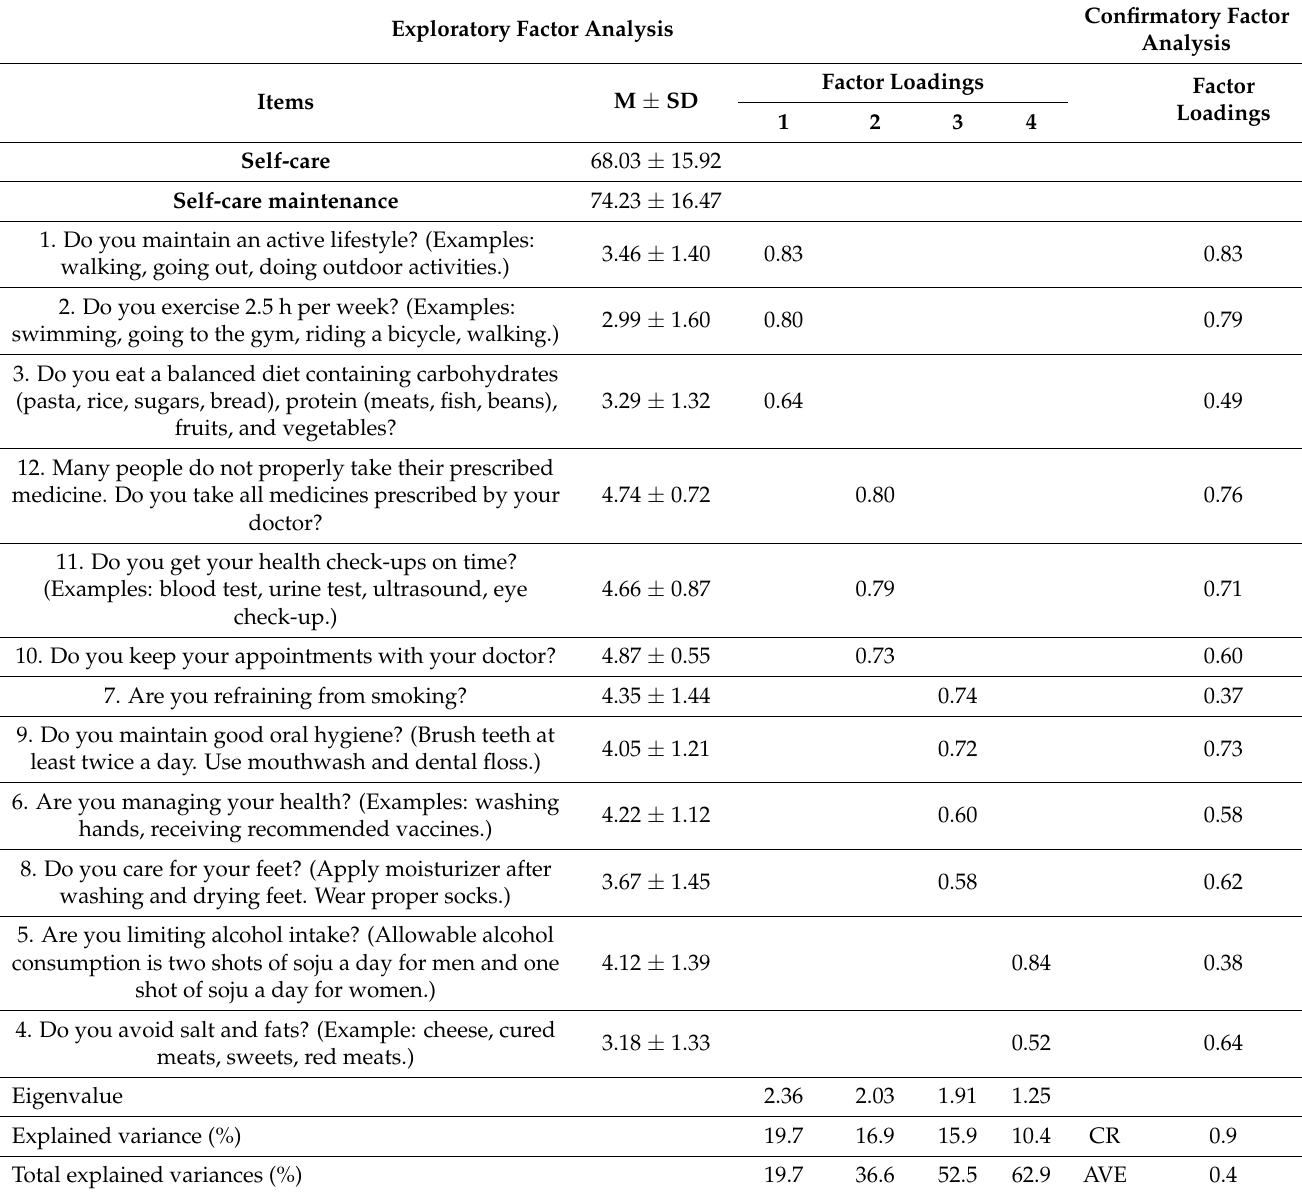
Table 2. Exploratory Factor Analysis and Confirmatory Factor Analysis of SCODI-K ( N = 210). Exploratory Factor